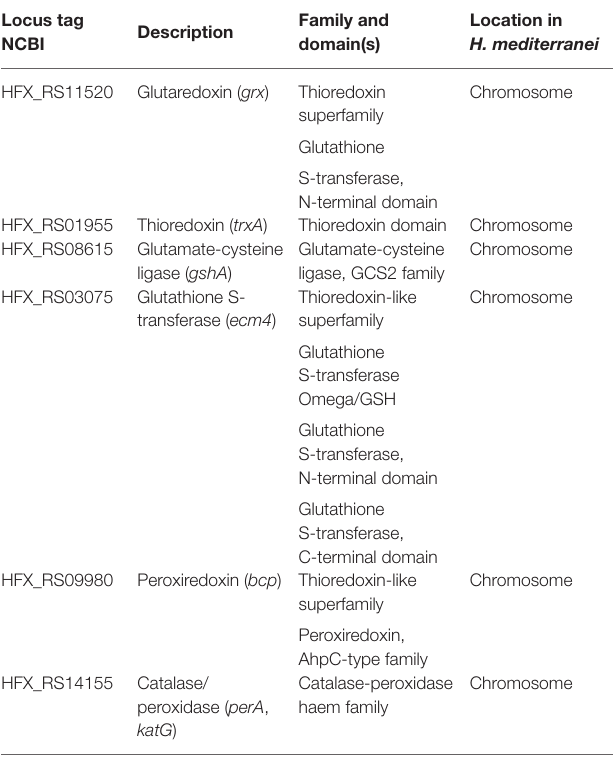
Family and conserved domain(s) have been collected from InterPro, Pfam, and NCBI protein databases. The Query protein targeted belongs to the H. mediterranei strain used in this